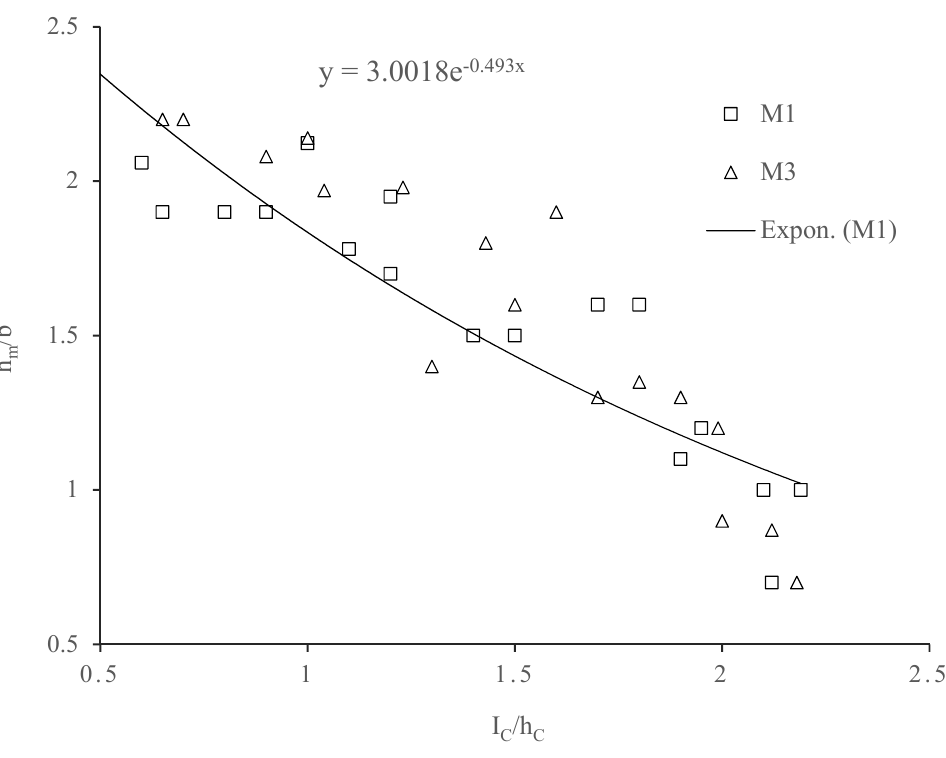
Figure 7. Relationship between the ratio of the rooster tail height to the width of the pier (h m / b ) and I c / h c .